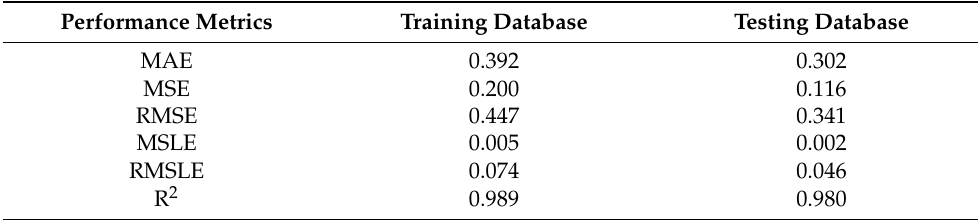
Table 7. Results of ANN predictions of the CBR for mixtures of alum sludge and soil.